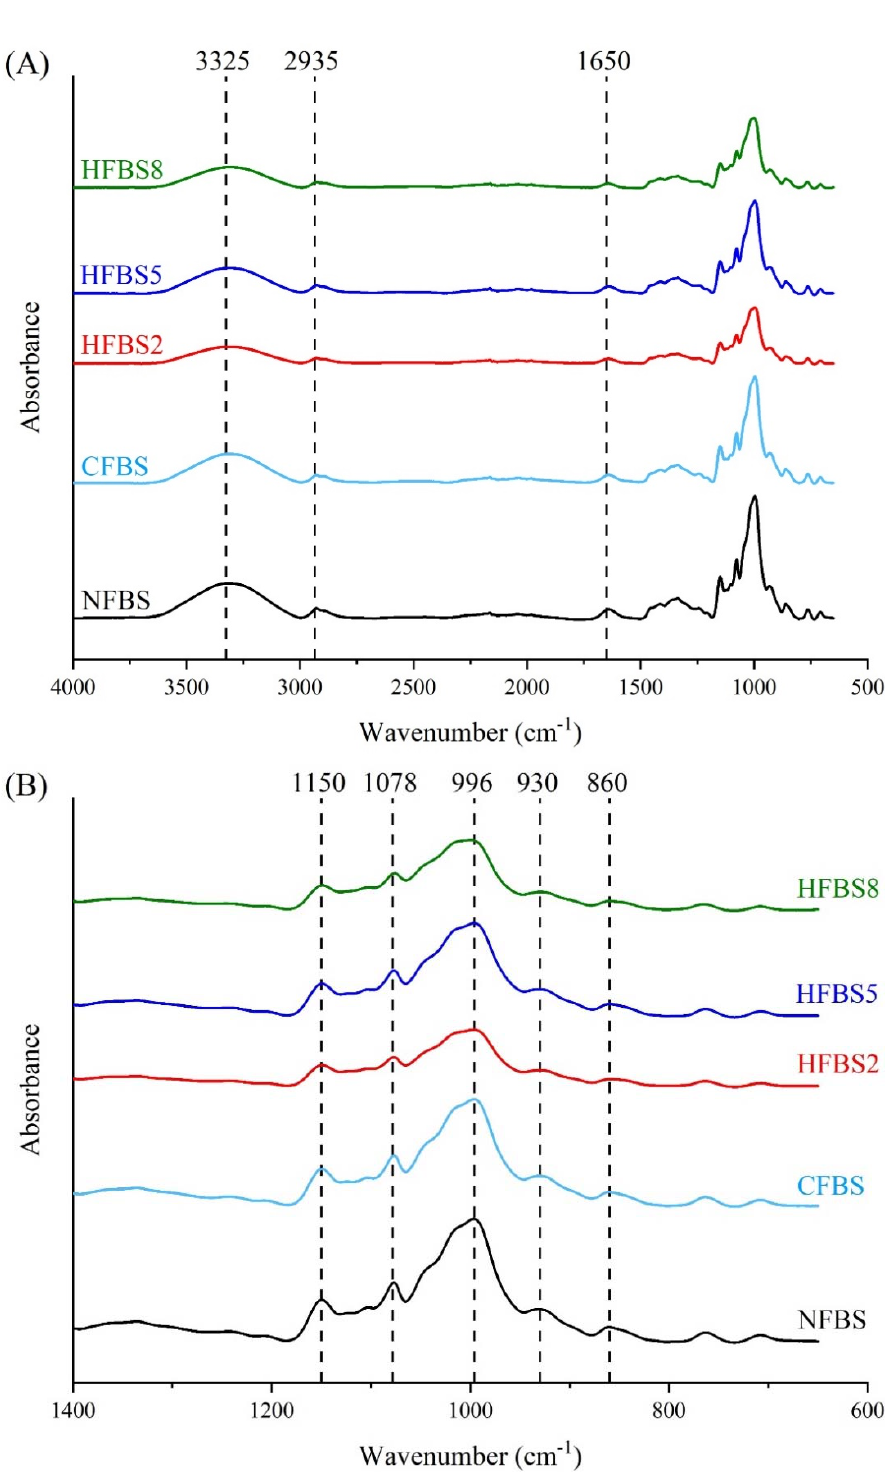
Figure 4. FTIR spectra. ( A ) Patterns of native and hydrolyzed faba bean starches. ( B ) The fingerprint characteristic peaks. NFBS, native faba bean starch; CFBS, conventional hydrolysis faba bean starch; HFBS2, HFBS5, and HFBS8, hydrolyzed faba bean starches.